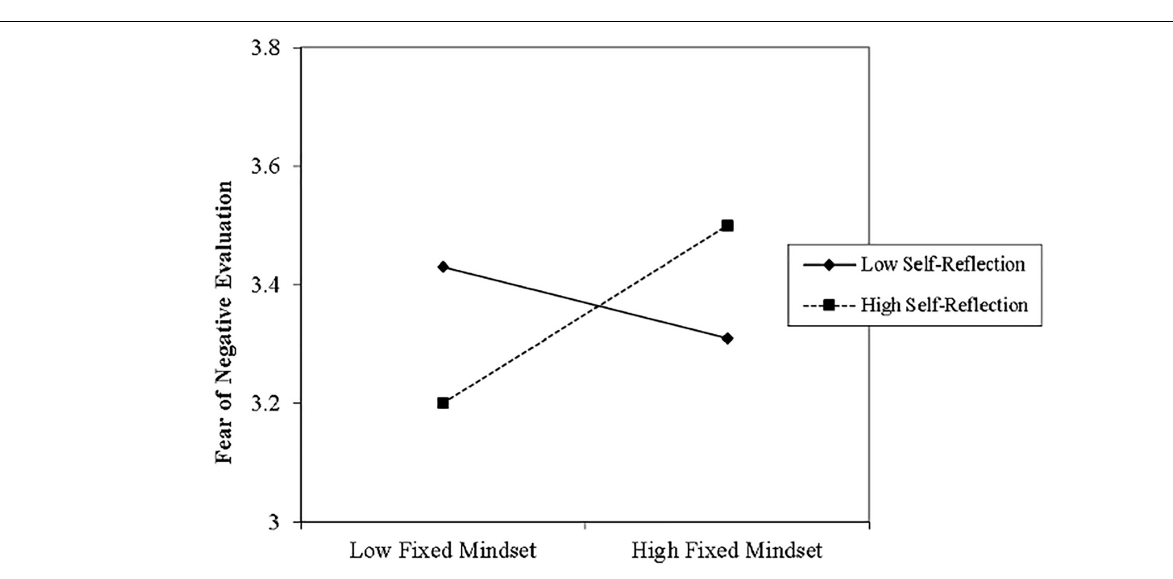
FIGURE 1 | Effect of self-regression on growth mindset and fear of negative evaluation.